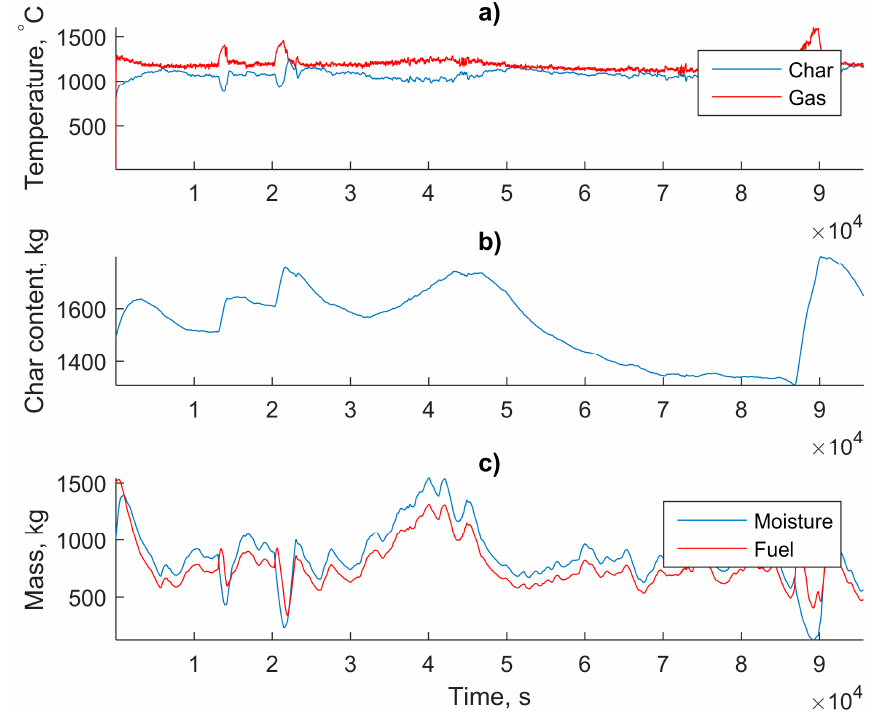
Figure 7. Model states during the validation: ( a ) char and gas temperatures, ( b ) amount of char, and ( c ) fuel and moisture content.